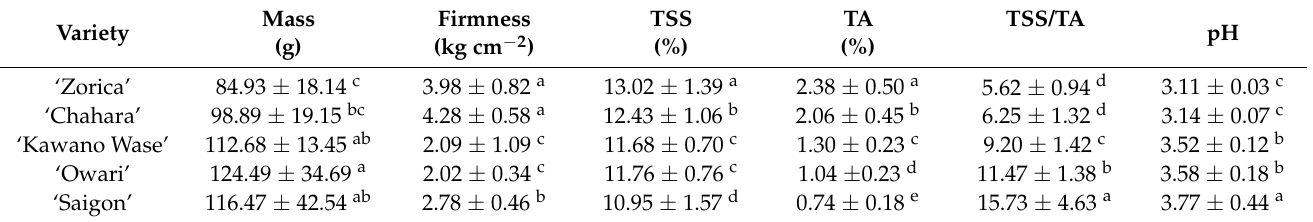
Table 1. Physicochemical properties in different varieties of mandarin fruits from Neretva